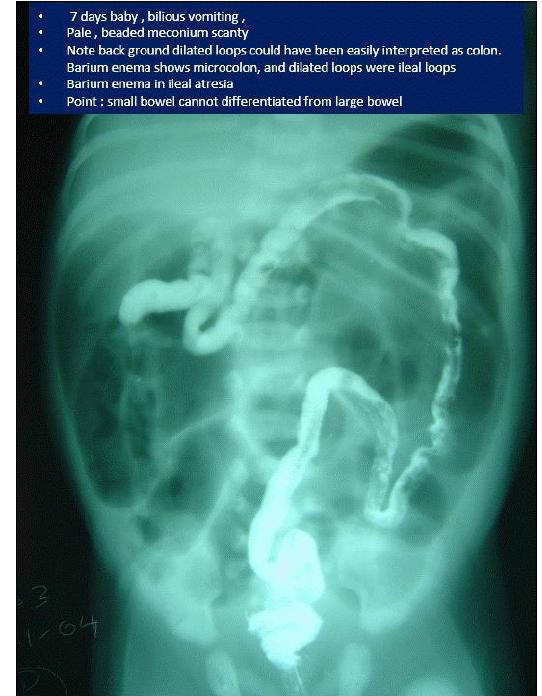
Figure 11: Barium enema showing microcolon in a case of ileal atresia.